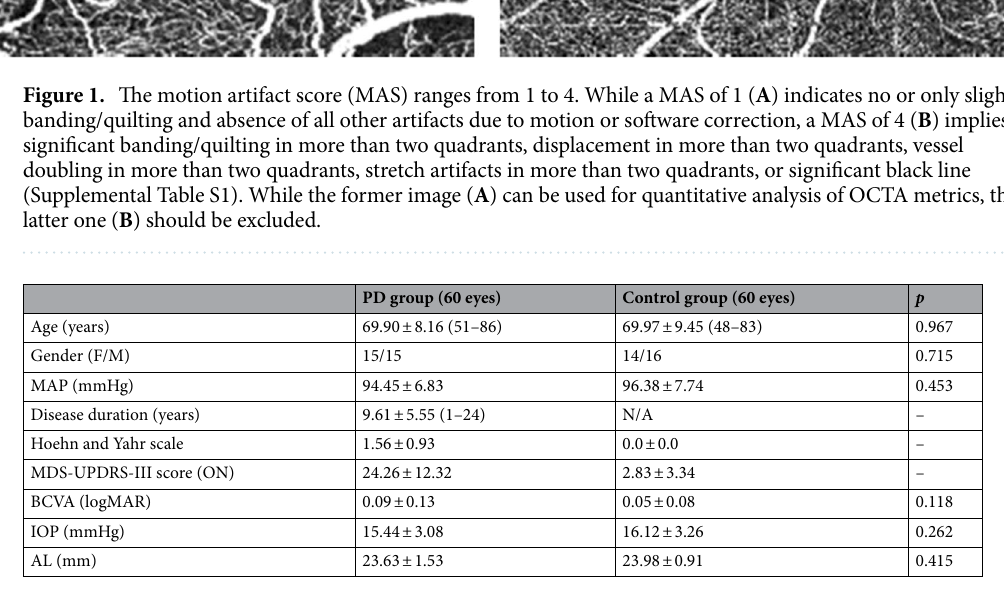
Table 1. Demographic and clinical data. AL axial length, BCVA best-corrected visual acuity, F female, IOP intraocular pressure, logMAR logarithm of the minimal angle of resolution, M male, N/A not applicable, MDS-UPDRS Movement Disorder Society Unified Parkinson’s Disease Rating Scale; Results are reported as mean ± standard deviation (range). p < 0.05 was considered statistically significant.